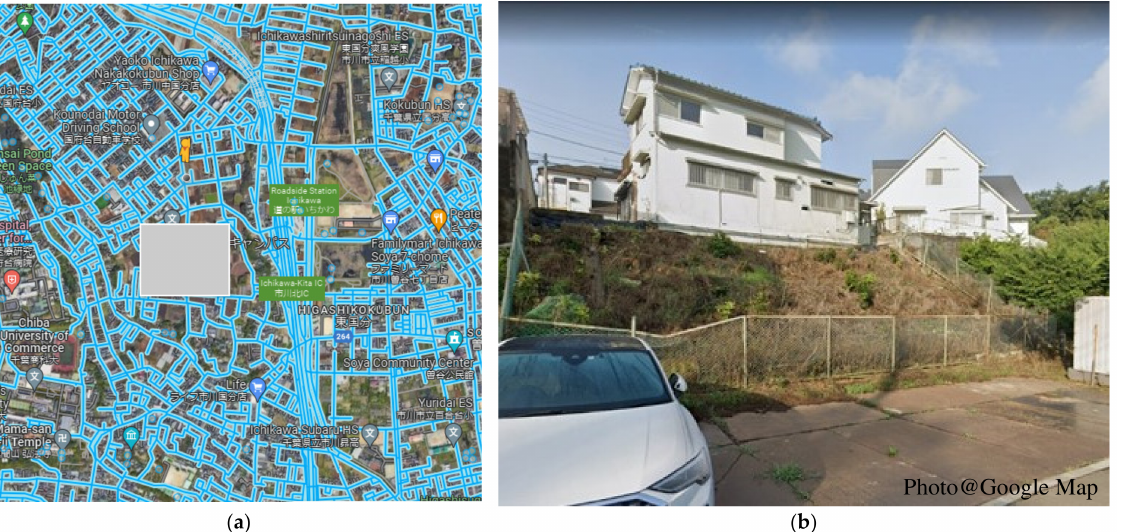
Figure 14. Advantages of GSV in detecting and identifying IGSs: ( a ) a single person can perform this method, even with a drag-and-drop “pegman”; ( b ) IGSs can be easily observed in standard view. (The photos are taken from same location in Japan, so the names come with both English and